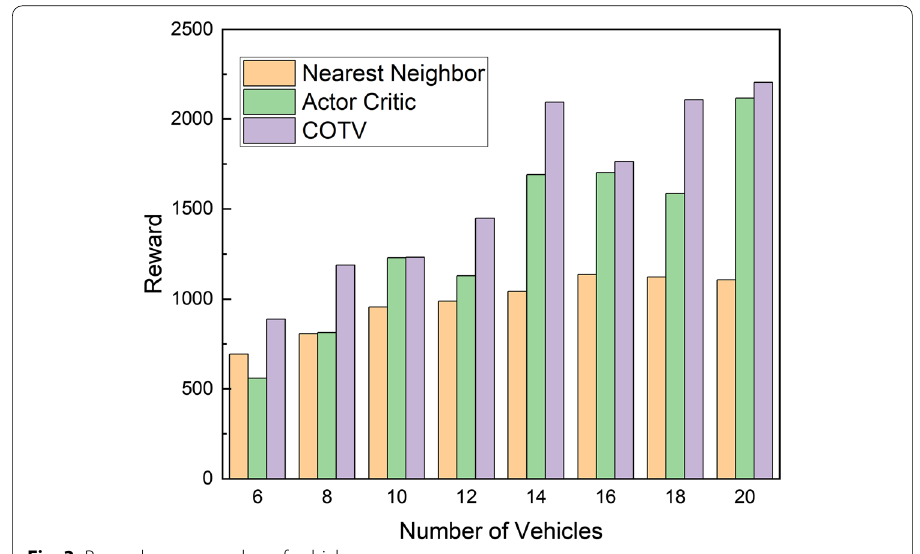
Fig. 3 Reward versus number of vehicles